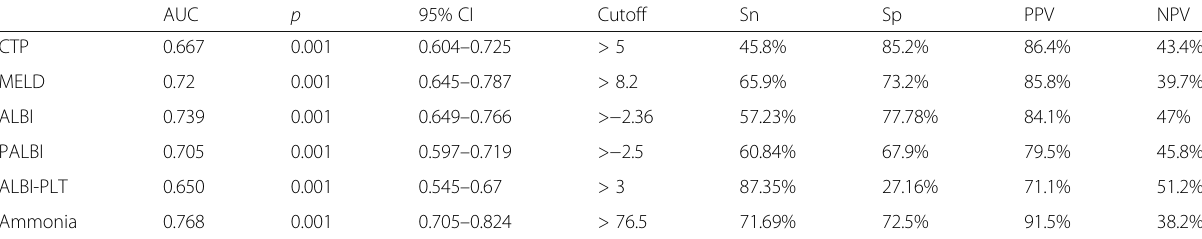
Table 3 Receiver operating characteristic (ROC) curve analysis of ALBI, PALBI, ALBI-PLT and ammonia in patients with and without MHE